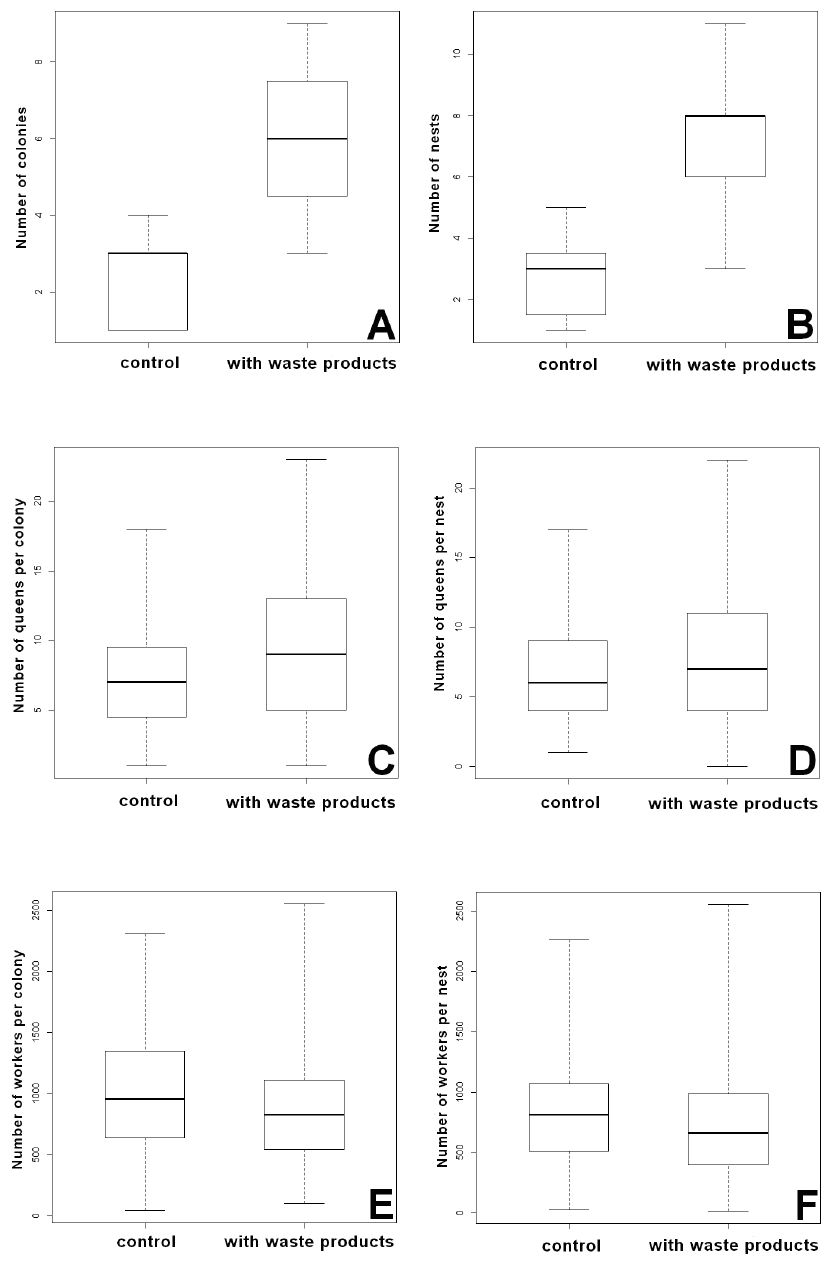
Figure 1. Variation of measured nest parameters between control plots and plots with waste products in Myrmica rubra . A colony density (P < 0.0001) B nest density (P < 0.0001) C number of queens per colony (P = 0.06) D number of queens per nest (P = 0.26) E number of workers per colony (P=0.32) F number of workers per nest (P = 0.06). Numbers are given as median per plot (per 100 m 2 ), whiskers of the boxplot represent the range of minimum and maximum